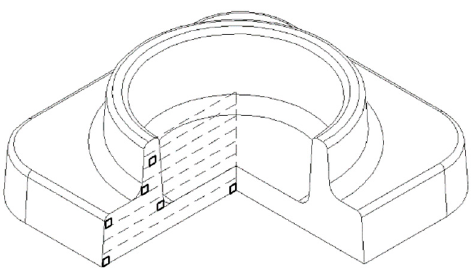
Figure 5. Diagram of the studied zones in the flange forging layers (numbering of eight layers from bottom to top).